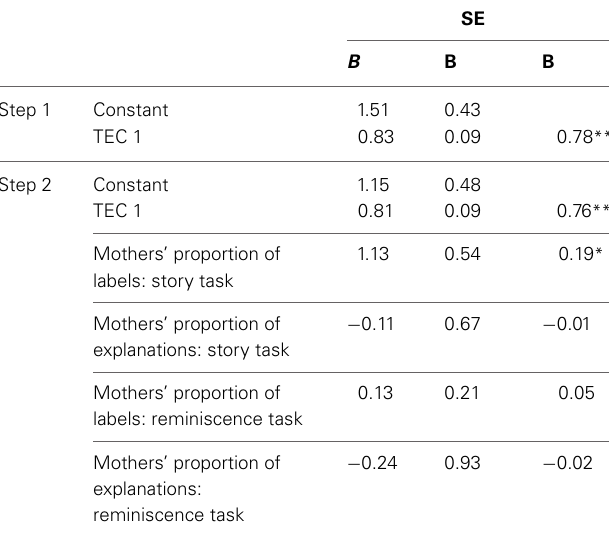
Table 4 | Regression model predicting children’s emotion understanding from maternal talk.